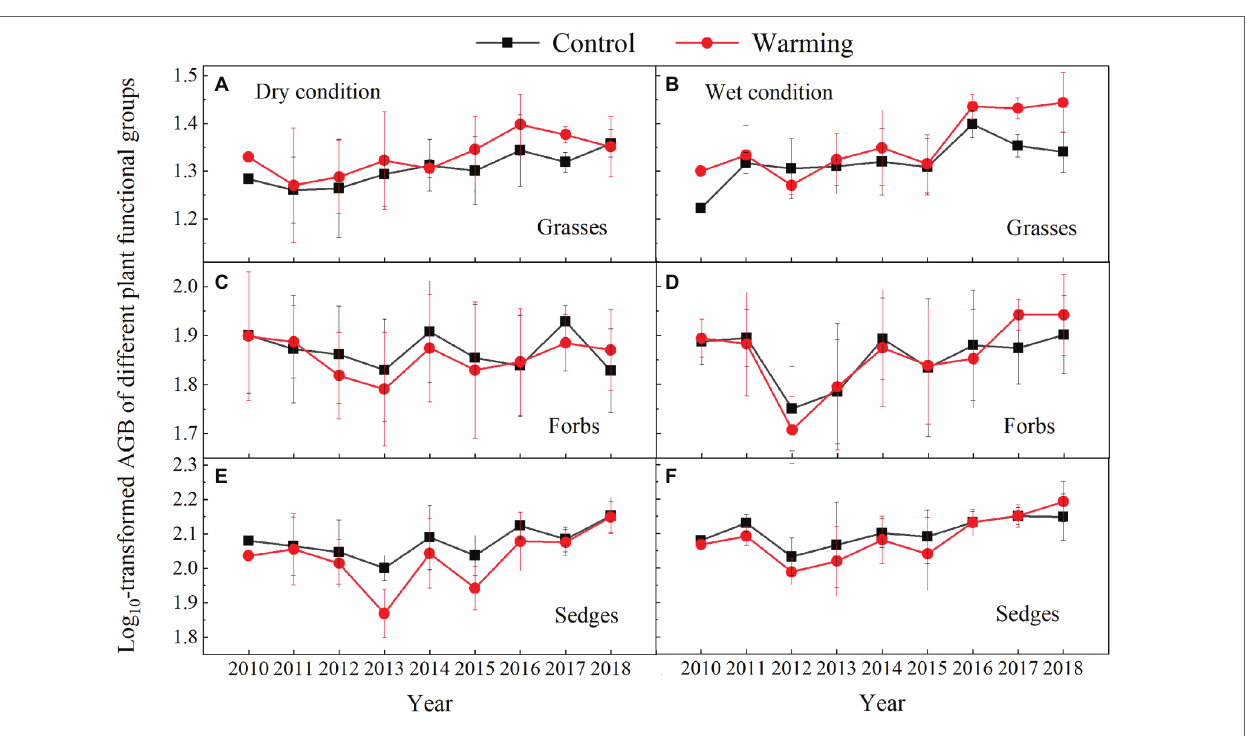
FIGURE 5 | Aboveground biomass of grasses (A,B) , forbs (C,D) , and sedges (E,F) in control and warmed plots in the dry (A,C,E) and wet (B,D,F) conditions from 2010 to